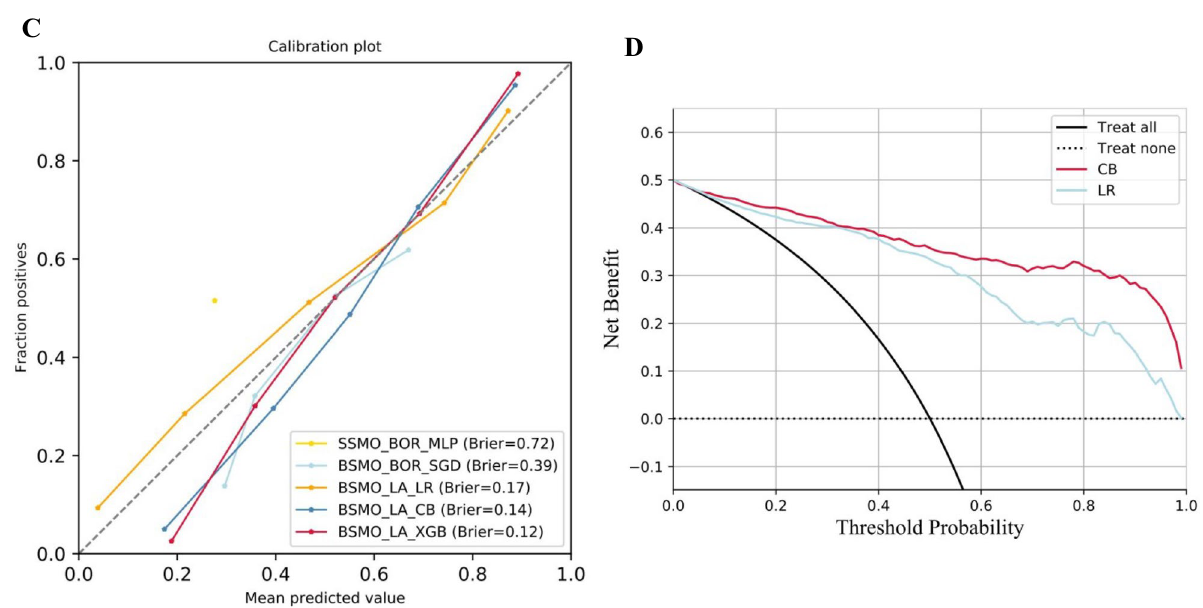
Figure 1. The performance of the five best models. ( A ) The ROC curves of the five best models. ( B ) The precision-recall curves of the five best models. ( C ) The calibration curves of the five best models. ( D ) Decision curve analysis of the models. SMOTE synthetic minority oversampling technique, BOR boruta screening, MLP multiple-layer perceptron, BSMOTE borderline synthetic minority oversampling technique, SGD stochastic gradient descent, LA lasso screening, LR logistic regression, XGB extreme gradient boosting, CB category boosting, AUC area under the curve, AUPRC area under the precision-recall